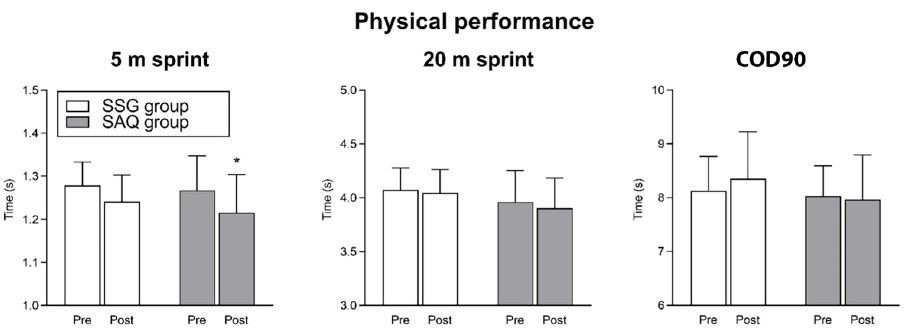
Fig 5. Effect of training intervention on perceptual speed (reaction time for 5, 10, 15 and 20 items conditions in the visual search task). Post < pre by Bonferroni post-ho c tests: � P < 0.05.